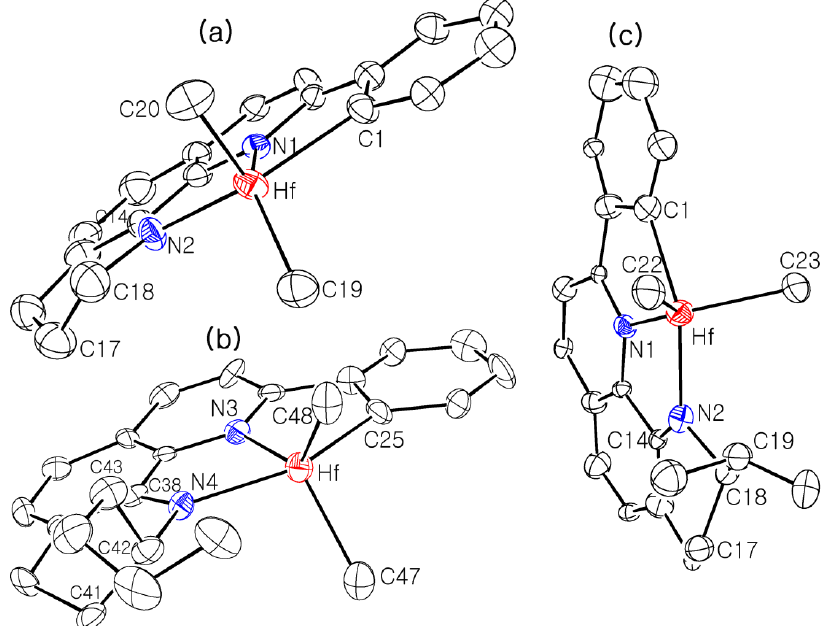
Figure 3. Thermal ellipsoid plot (30% probability level) of 10 ( a ), 11 ( b ), and 12 ( c ). Hydrogen atoms